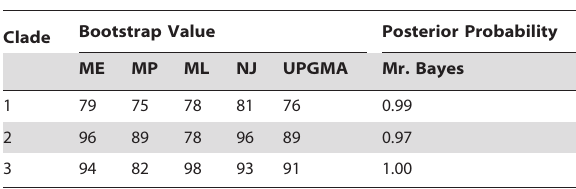
Table 2. Support values from all phylogenetic analyses for the three well-supported branches of the phylogeny in Figure 1.